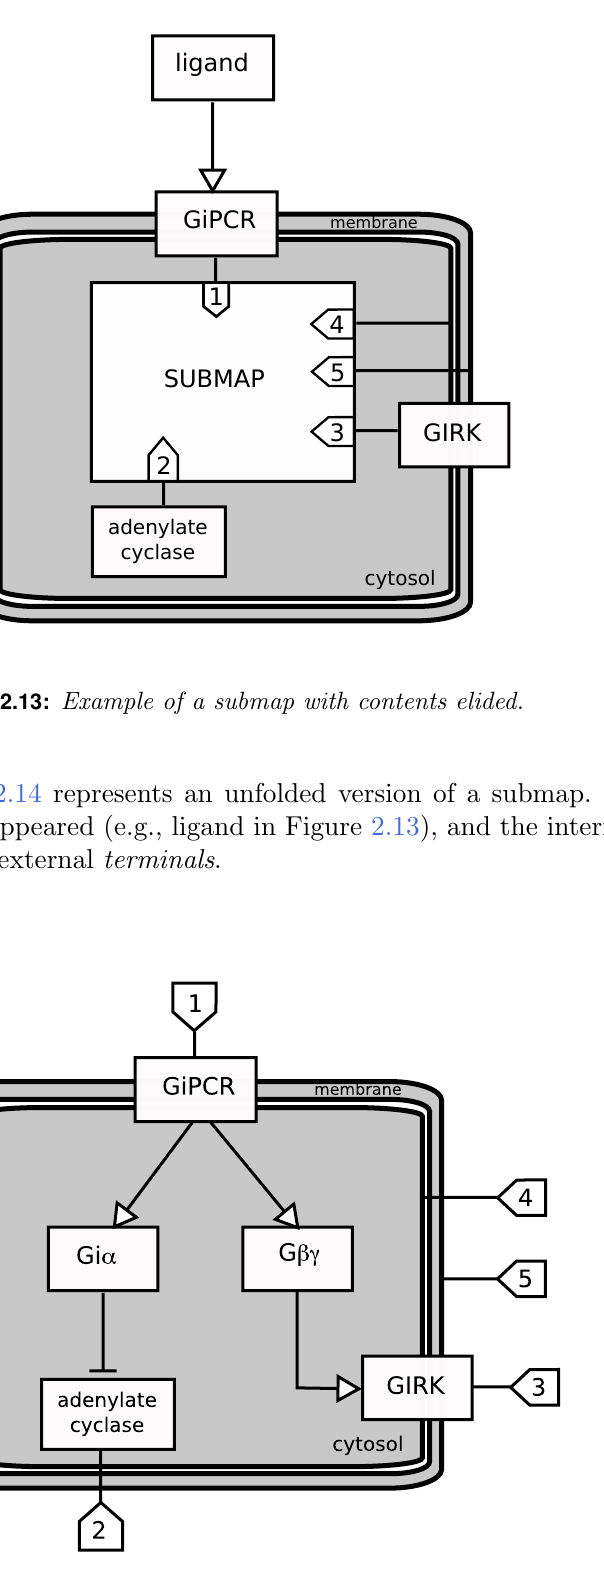
Figure 2.14: Example of an unfolded submap. The unfolded submap corresponds to the folded submap of Figure